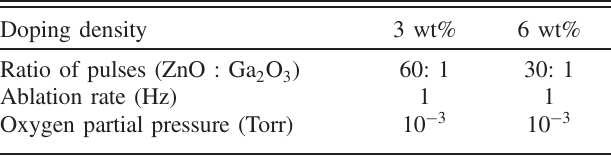
TABLE I. Typical deposition parameters for 3 wt% and 6 wt% GZO. Doping density